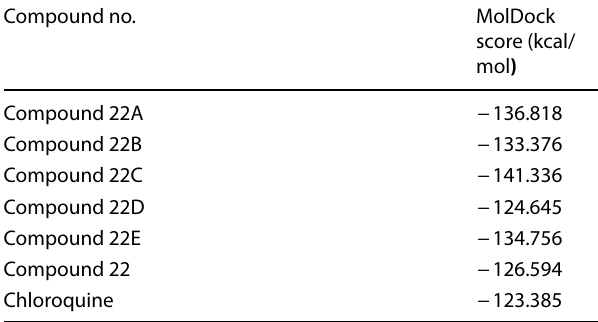
Table 5 Molecular docking results of the designed compounds Compound